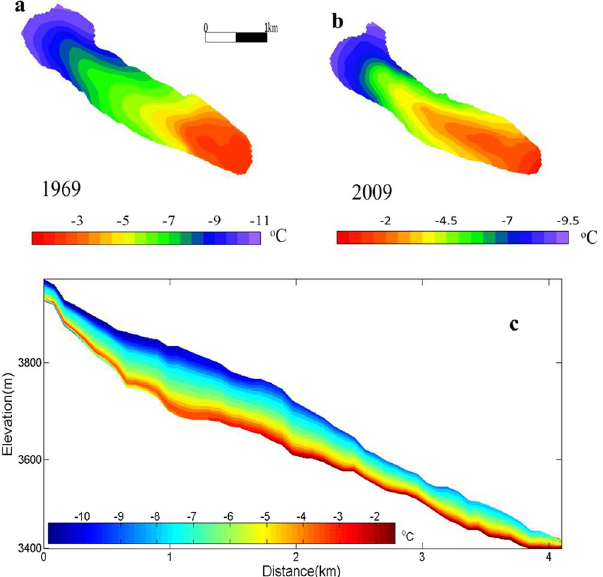
Figure 7. The simulated temperature. ( a ) The simulated temperature at the bottom in 1969; ( b ) the simulated temperature at the bottom in 2009; ( c ) the ice temperature distribution in the mainstream line in